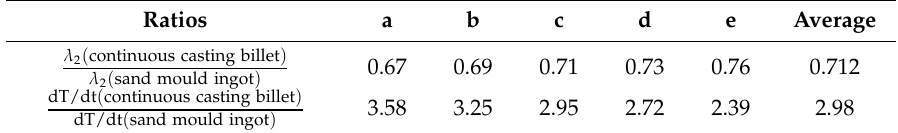
Table 2. Ratios of λ 2 and calculated cooling rate for the di ff erent samples of billets cast with the continuous caster and sand